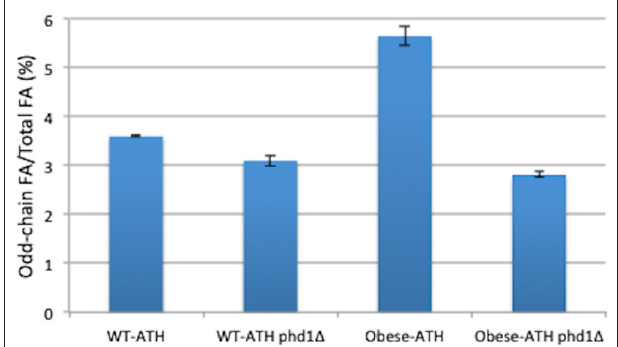
FIGURE 4 | Odd-chain fatty acid production in the PHD1 -disrupted strains. The percentage of odd-chain fatty acids (FAs) relative to total FAs in the PHD1 -disrupted strains and their respective controls. The results represent the means and standard deviations for two independent experiments.